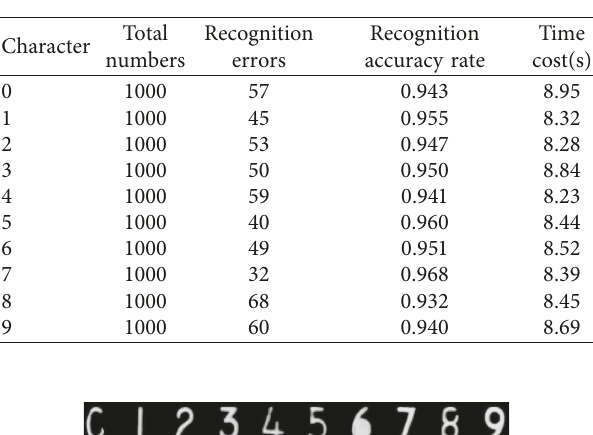
Figure 8: Character samples affected by illumination and back- ground